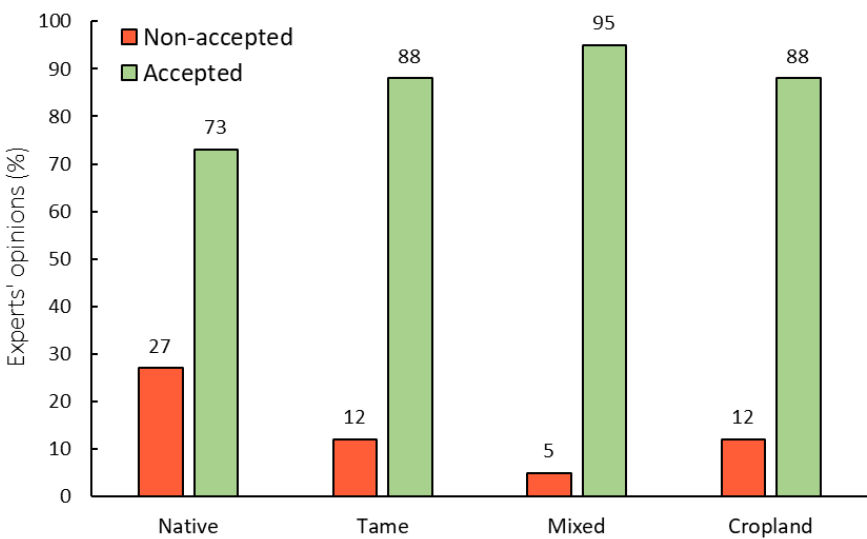
Figure 5. The accuracy assessment of the MGE classification, User’s Accuracy (%): This value represents the probability of a classified pixel into a given category represents that category on the ground, and the Producer’s Accuracy (%): This value represents how well reference pixels of the ground cover type are classified; ( a ) PLI classification; ( b ) AAFC 2017; ( c ) AAFC 2018; and ( d ) AAFC 2019.